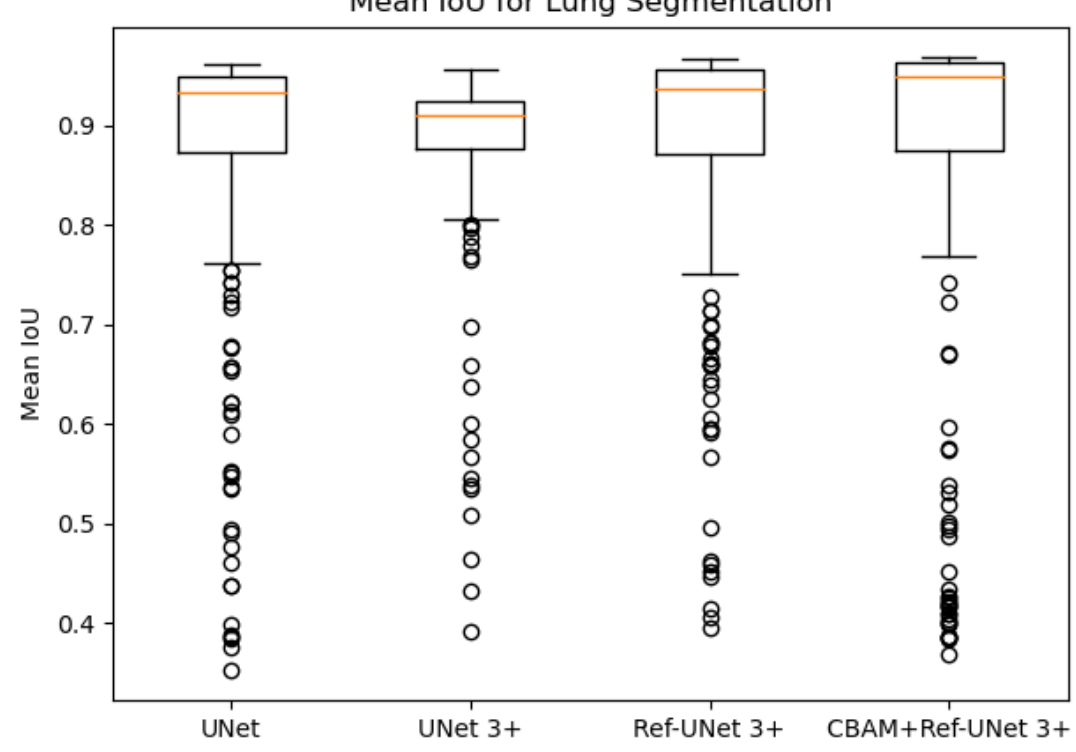
Figure 8. Training loss of the proposed models against UNet and UNet 3 +.